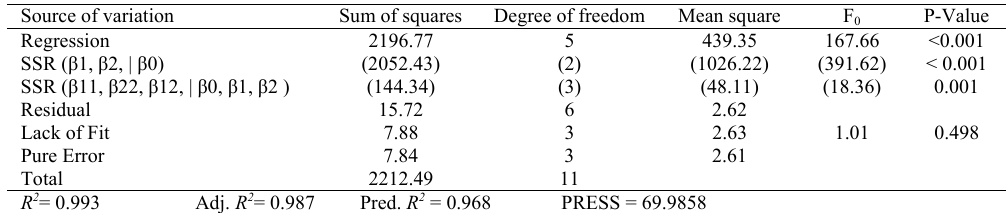
Table 6: Analysis of variance for the proposed model Source of